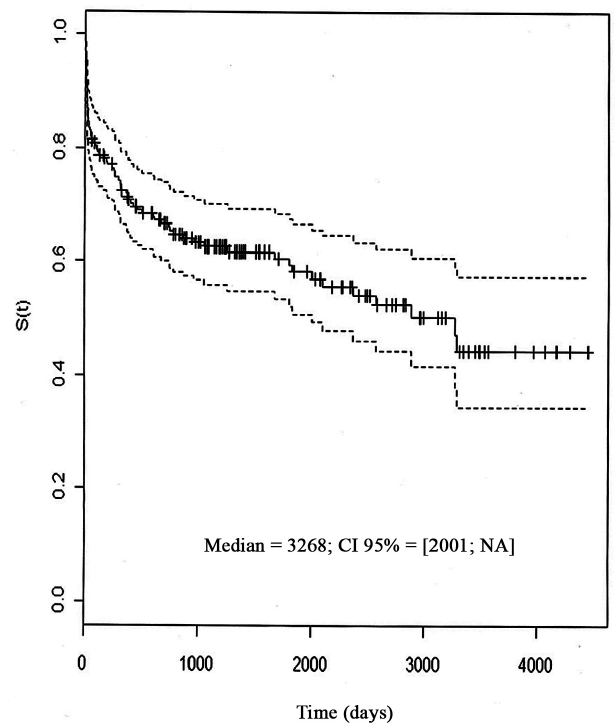
Fig. 1 - Kaplan-Meier curve for the survival time of